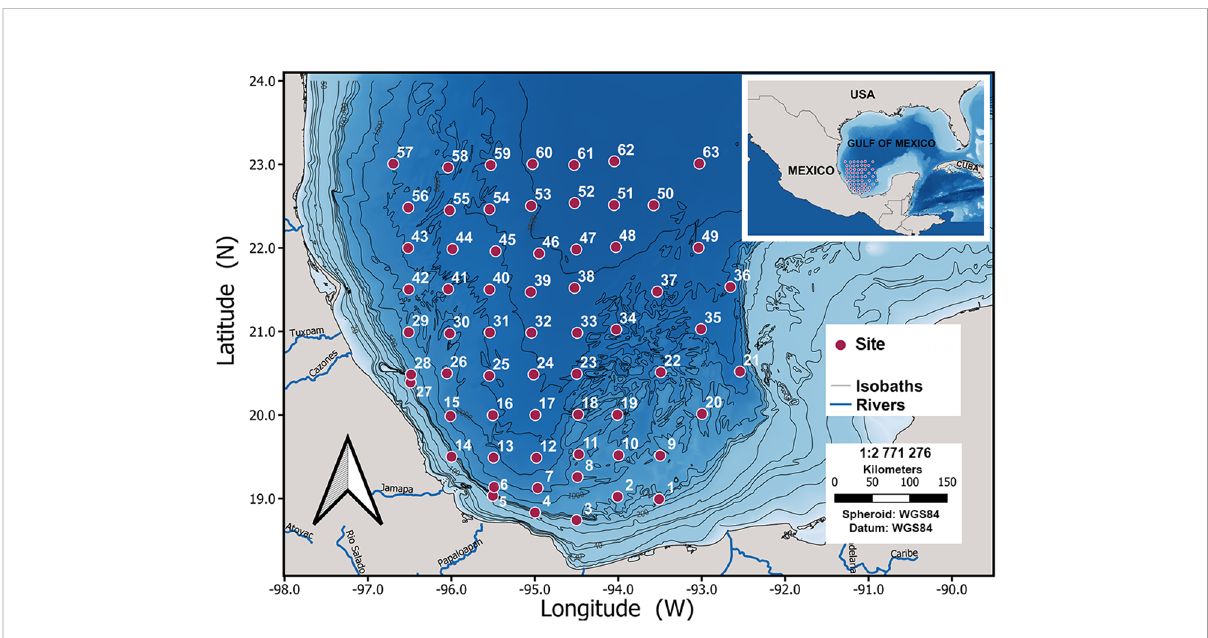
FIGURE 1 Map of the 63 study sites in the Southwestern Gulf of